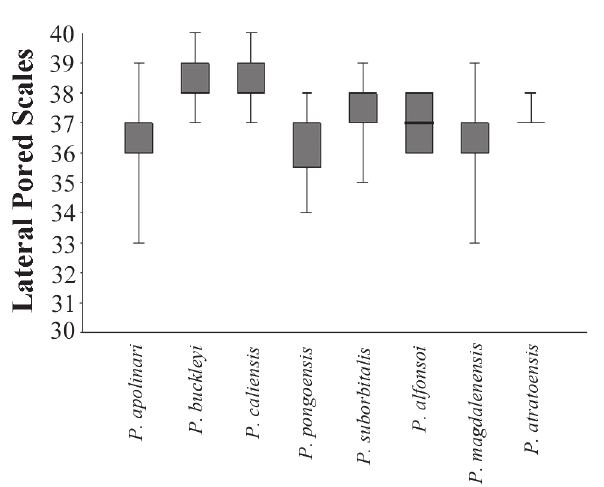
Fig. 12. Number of pored scales of lateral line of Colombian species of Parodon .